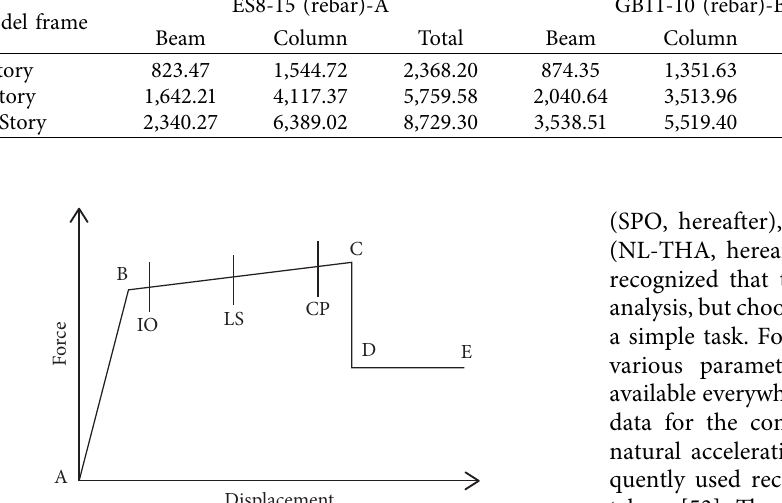
Figure 5: Force-deformation relationship of a plastic hinge [6,